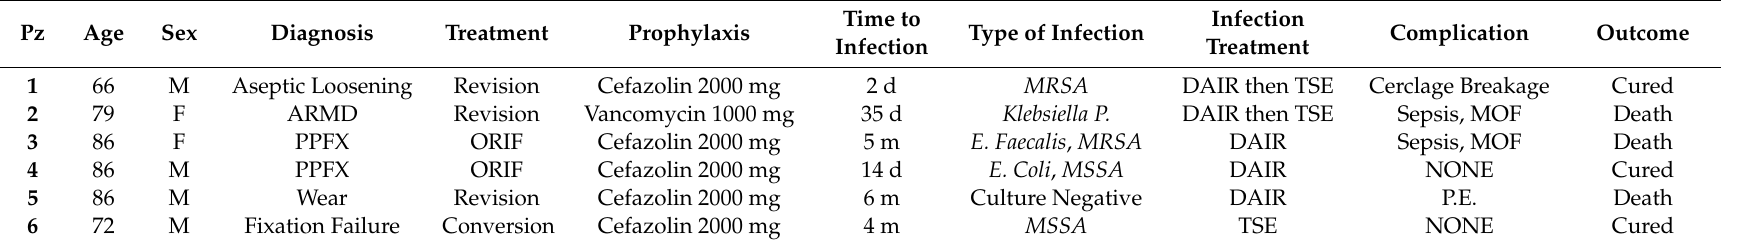
Table 6. Descriptive table of patients who developed postoperative periprosthetic joint infections